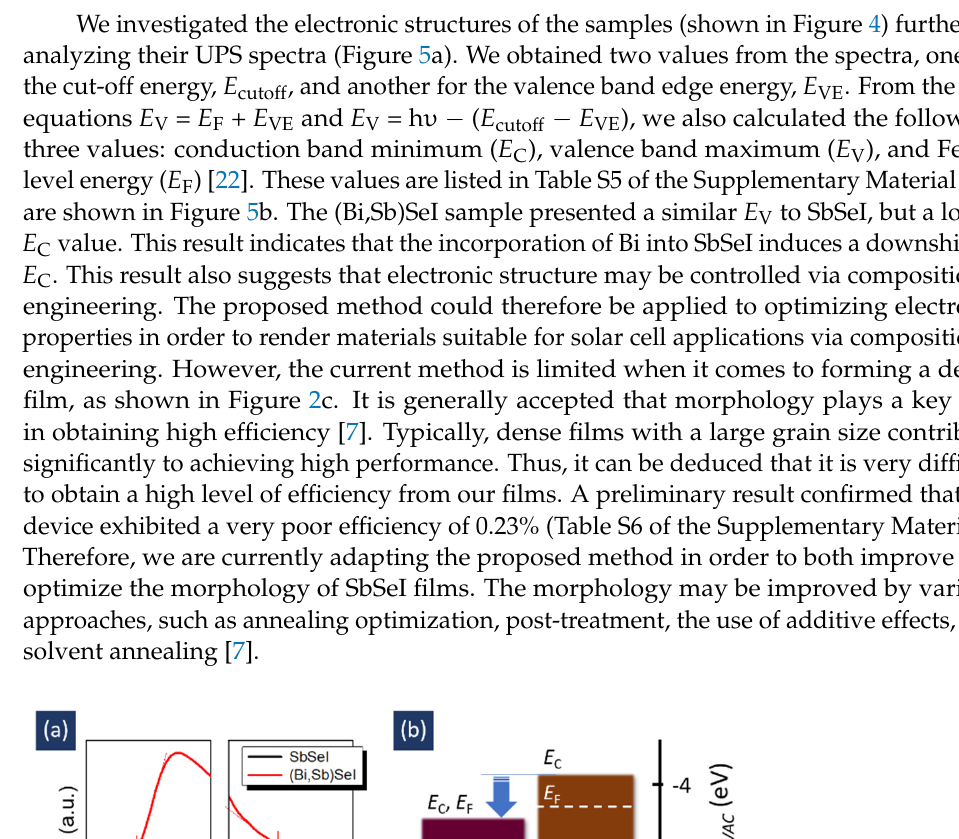
Figure 4. ( a ) Absorption spectra and ( b ) XRD patterns of control and Bi-SbSeI samples.